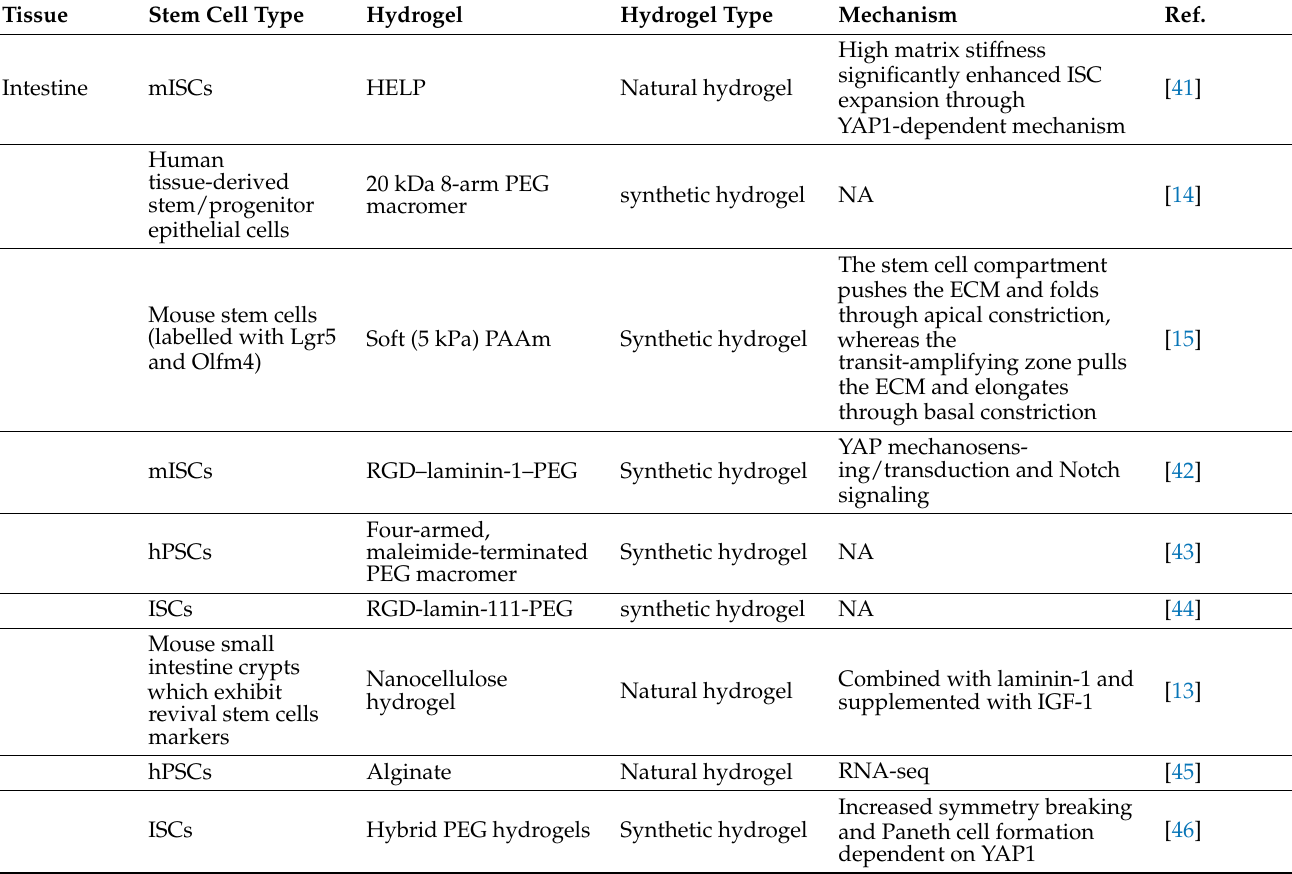
Figure 5. Publication years of included studies.